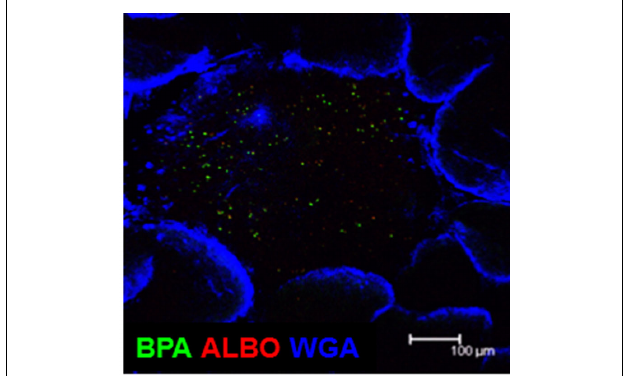
FIGURE 2 | Microarchitecture of murine Peyer’s patches. Whole-mount fluorescence in situ hybridization was performed to visually analyze the presence of Alcaligenes inside PPs. Both BPA and ALBO34a were used as specific probes for Alcaligenes .Wheat germ agglutinin (WGA), an N -acetylglucosamine-specific lectin, was used to detect epithelial cells. Scale bar indicates 100 μ m.